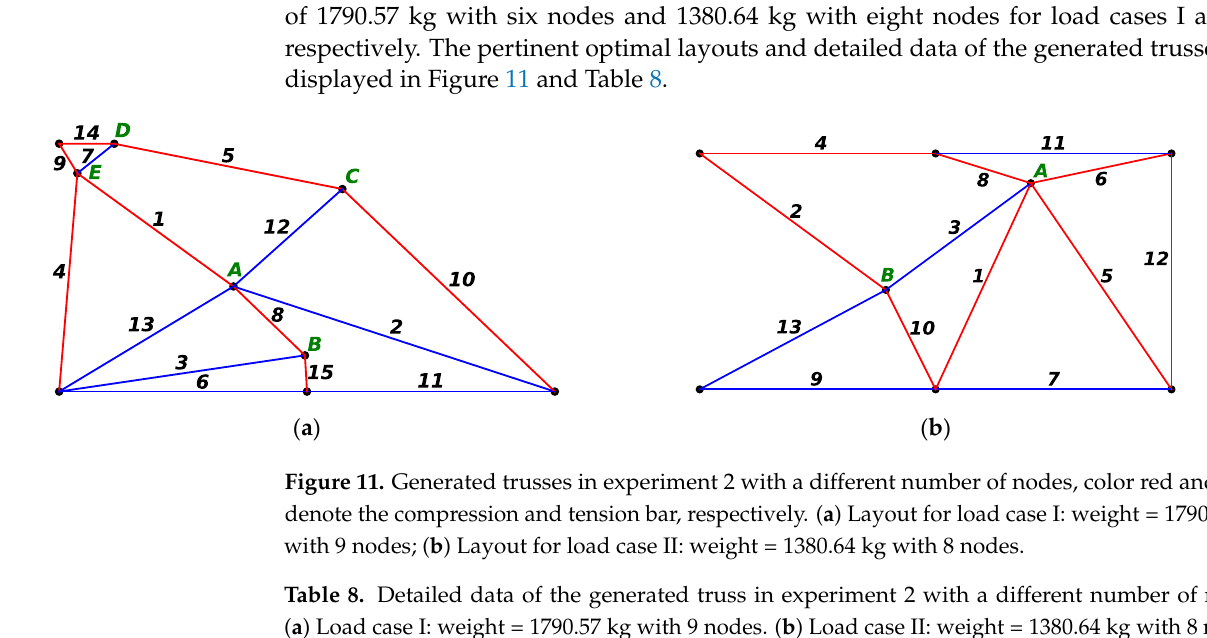
Figure 10. Best truss layouts found in literature, color red and blue denote the compression and tension bar, respectively. ( a ) Load case I with constraint combination I, adapted from Ref. [7]; ( b ) Load case I with constraint combination II, adapted from Ref. [9]; ( c ) Load case II with constraint combination I, adapted from Ref. [7].